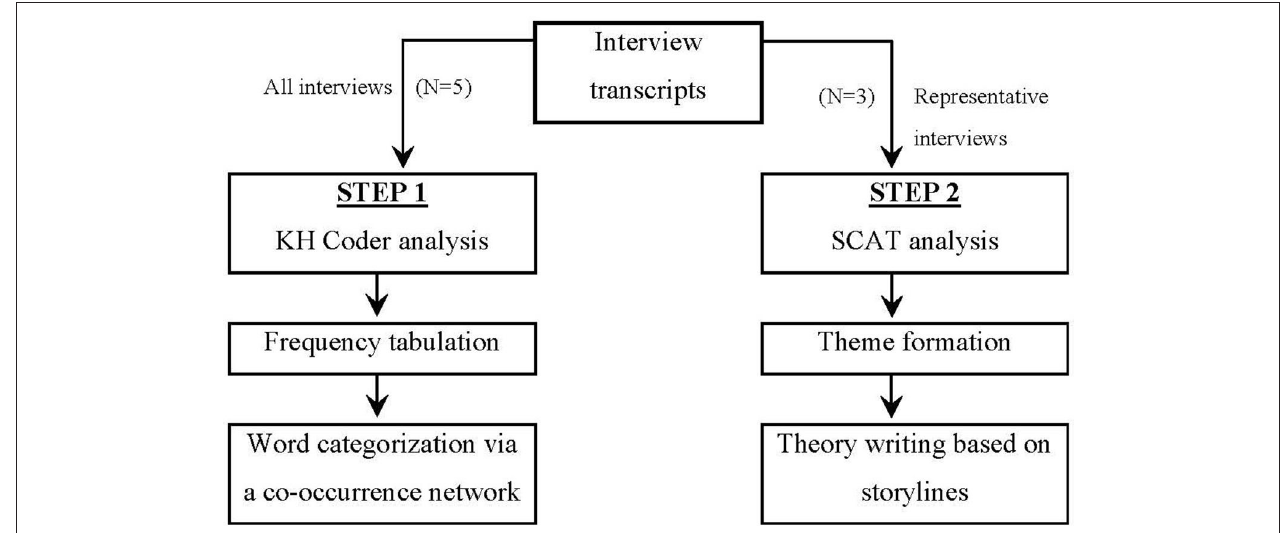
FIGURE 1 | Analysis flow. KH Coder, Text-mining software; SCAT, Steps for Coding and Theorization.